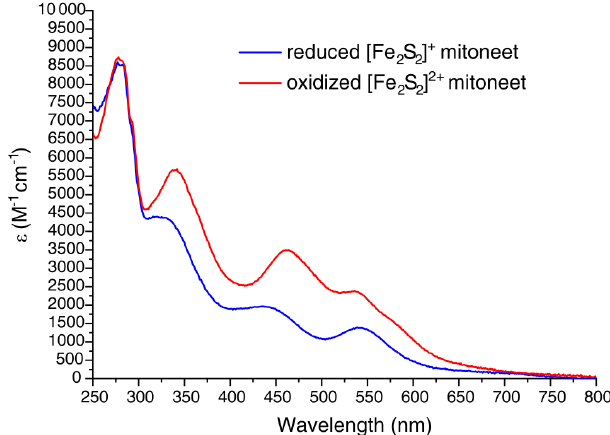
Figure A1. UV-visible spectra of reduced [ Fe 2 S 2 ] + - (blue line) and oxidized [ Fe 2 S 2 ] 2 + -mitoNEET (red line). ε values are based on monomeric protein concentration (determined with Bradford as- say).